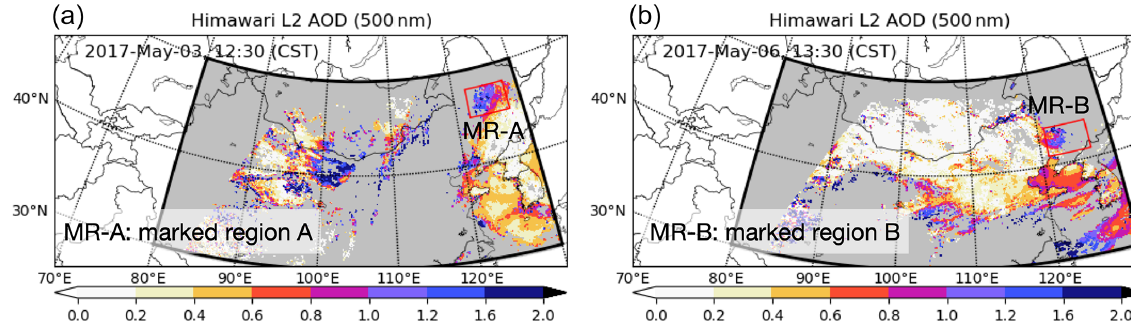
Figure 1. Two snapshots of Himawari-8 Level 2 AODs (500nm) on 3 May, 12:30 and 6 May, 13:30. Note that only observations within the black framework are included, where gray values denote pixels for which no AOD was